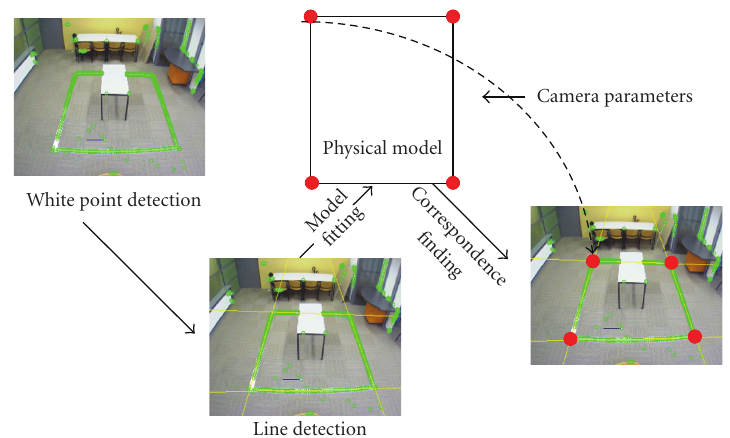
Figure 3: Example image of the corresponding homography based on camera calibration.